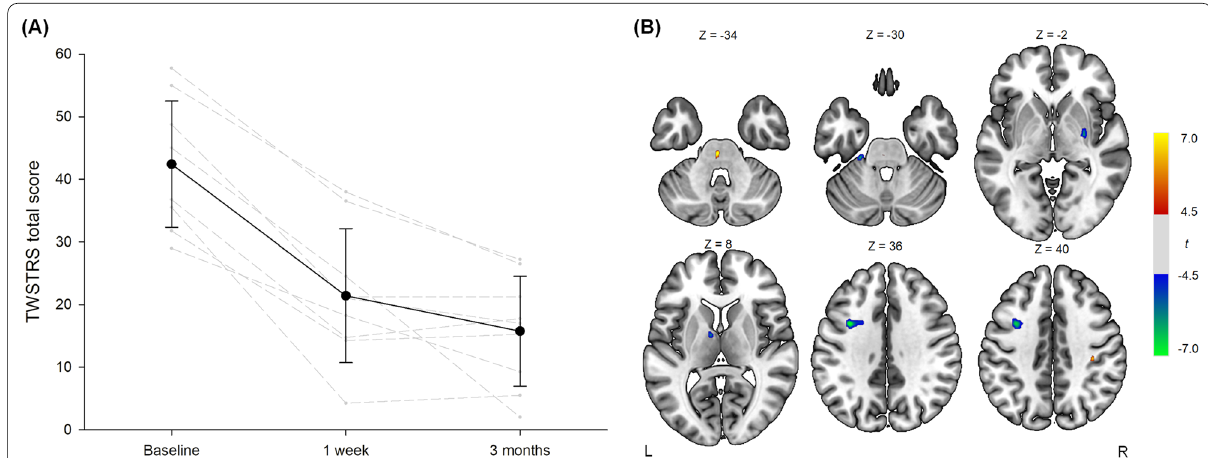
Fig. 1 A Changes of Toronto Western Spasmodic Torticollis Rating Scale (TWSTRS) total scores in patients with dystonia after pallidal deep brain stimulation. The gray dashed lines indicate the individual scores, and the black solid line and error bars show the mean scores and standard deviations, respectively. B Increases (red‑yellow) and decreases (blue‑green) of regional cerebral blood flow in patients with dystonia after pallidal deep brain stimulation. The axial brain slices with significant clusters are shown in neurological convention. The color bar indicates t‑values at each voxel. L, left; R, right